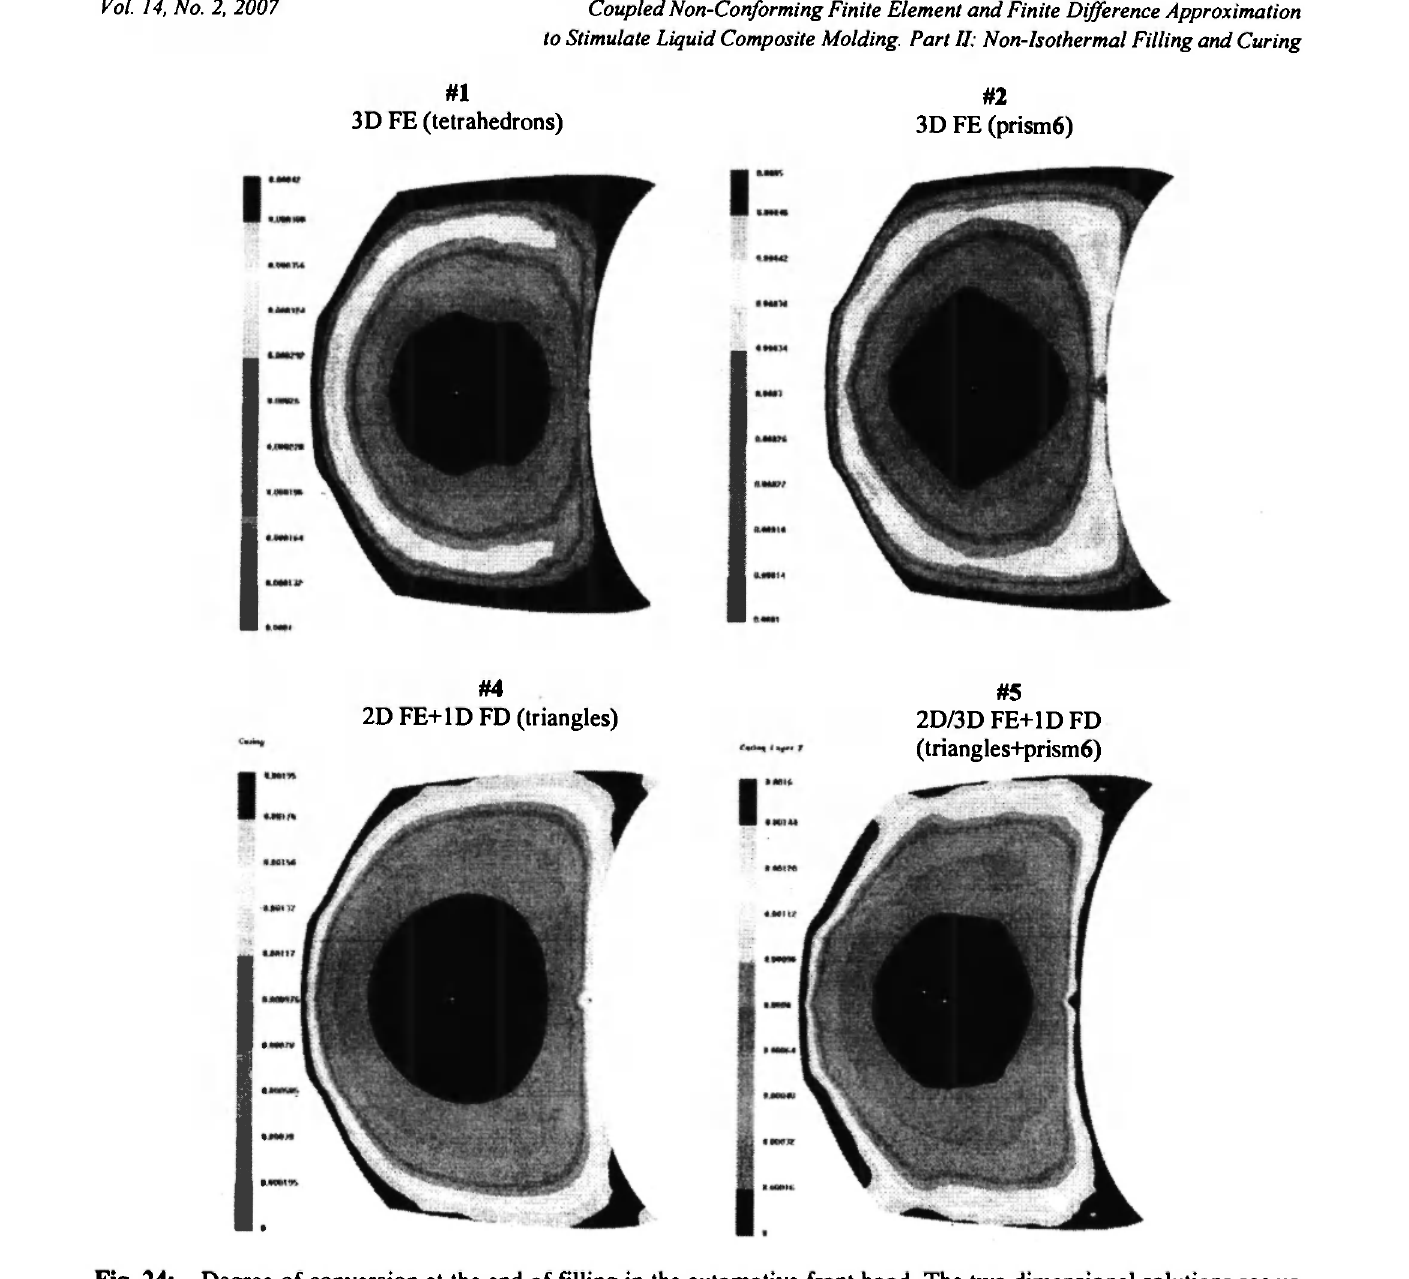
Fig. 24: Degree of conversion at the end of filling in the automotive front hood. The two dimensional solutions seems to better account for cure transport at flow front.